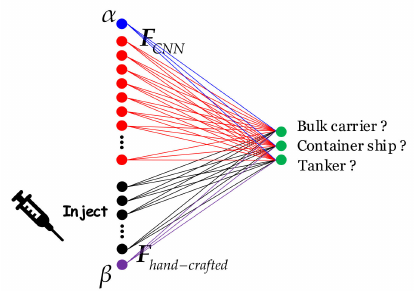
Figure 12. Diagrammatic sketch of the weighted concatenation